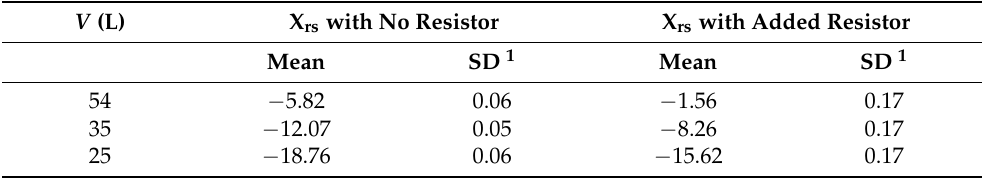
Table 1. Summary of the detected values of X rs (cmH 2 O ∙ s/L).